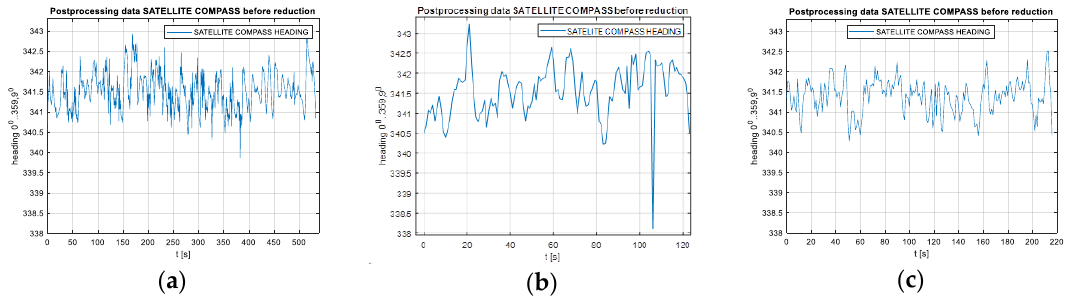
Figure 13. Raw heading records for the Novatel compass for the speeds of 10 km/h ( a ), 20 km/h ( b ) and 30 km/h ( c ).